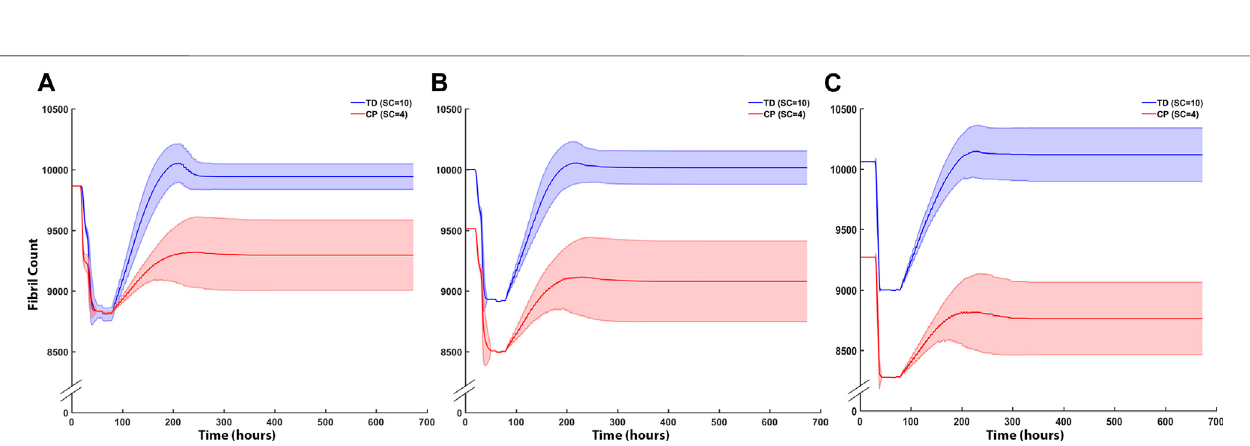
FIGURE 7 | ABM simulated cell counts over time. (A) SC simulation results (mean ± SD) compared to Snijders et al. (Snijders et al., 2015) (B) Simulated in fl ammatory cell counts of neutrophil and macrophage (mean ± SD) over time (solid line) compared to the generalized time course of when neutrophil, M1 macrophage and M2 macrophage cell counts are above 20% from baseline (dashed line), adapted from (Wosczyna and Rando, 2018).